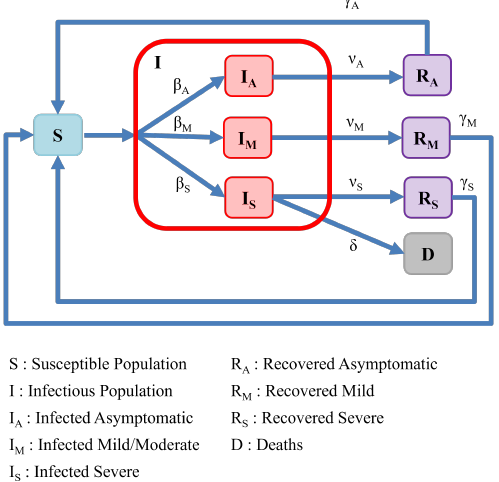
Figure 3. Model of population interactions with different levels of